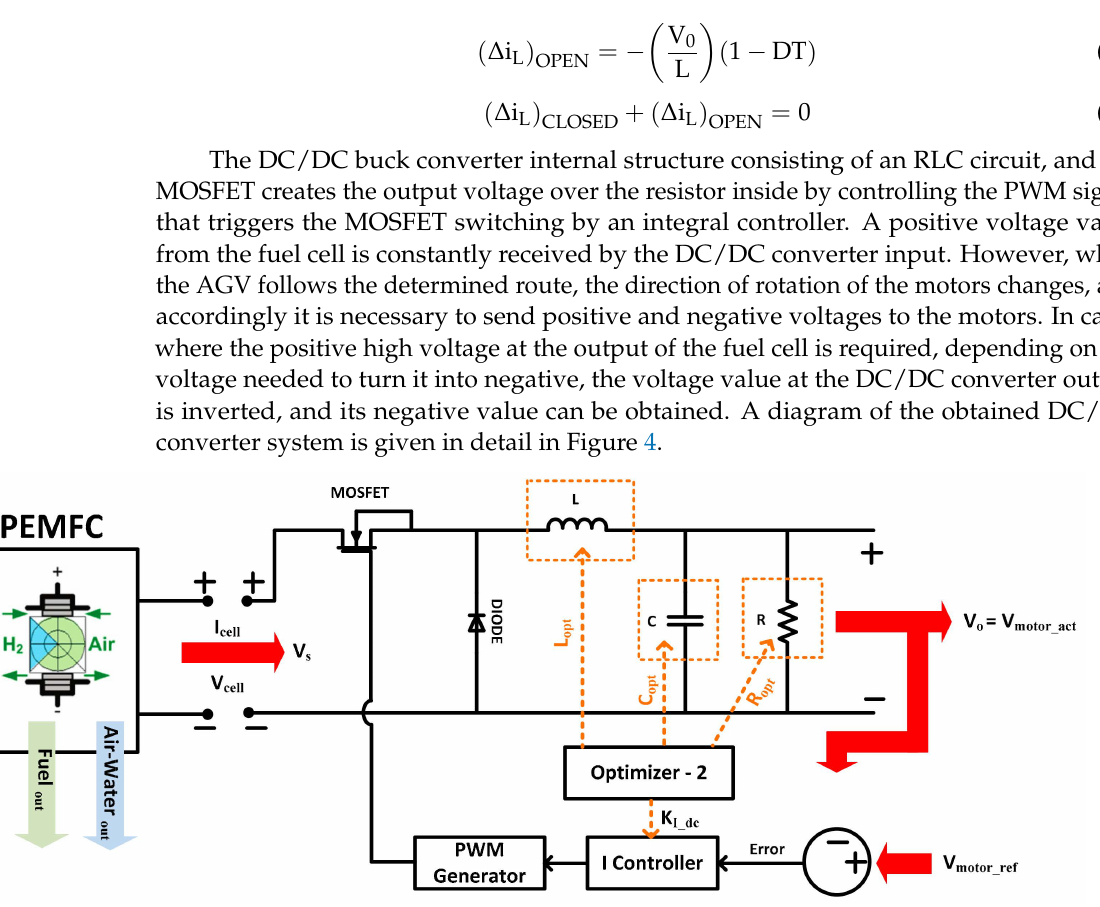
Figure 4. Block diagram of DC/DC buck converter jth (j = 1, 2, 3,